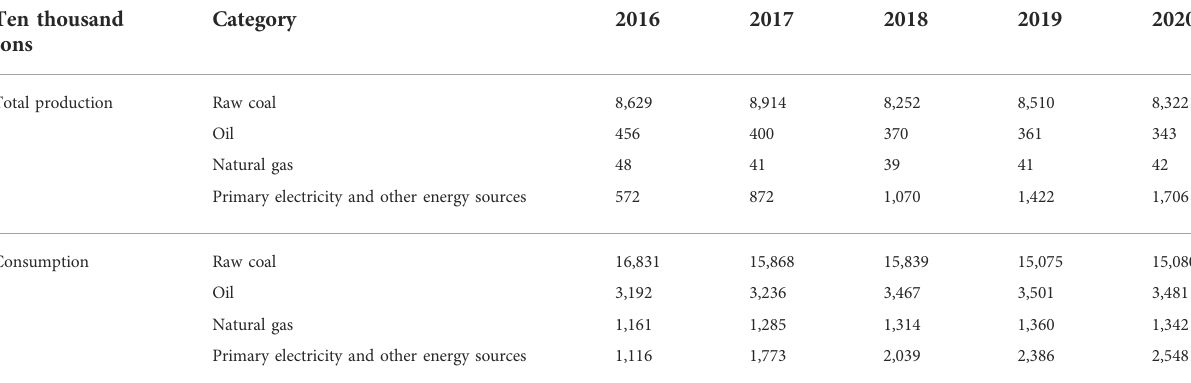
TABLE 2 Comparison of total primary energy production and consumption in Henan Province from 2016 to